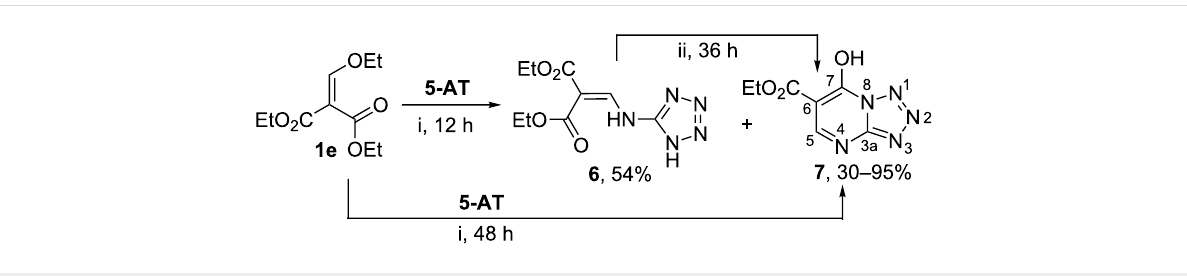
Scheme 3: Interaction of 2-ethoxymethylidene malonate 1e with 5-AT . Conditions: i: EtOH, Et 3 N, Δ ; ii: EtOH, Δ .